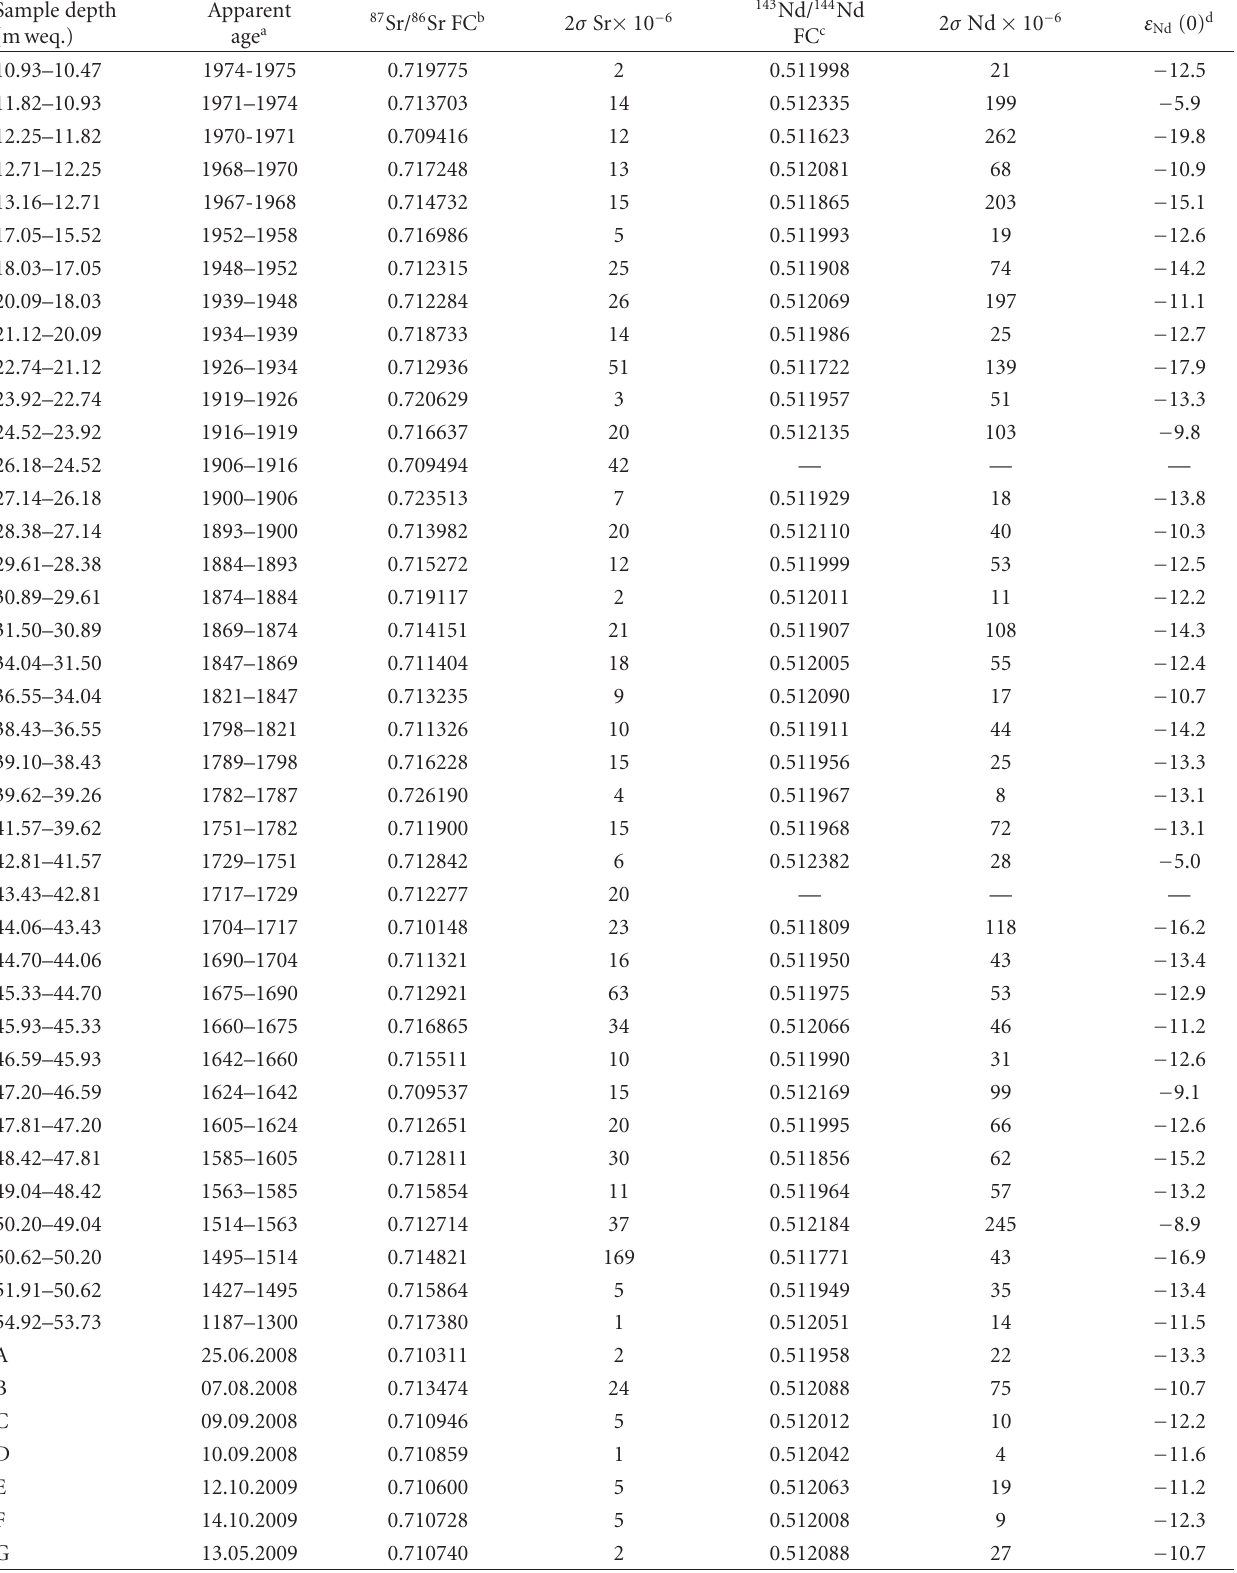
Table 1: Sample depth (meter water equivalent, mweq.) for the Colle Gnifetti (CG) ice-core samples (upper part), sample name for the Jungfraujoch (JFJ) samples (lower part), age of sample, 87 Sr/ 86 Sr and 143 Nd/ 144 Nd isotopic compositions with 2 σ (2 standard errors of the mean), and Nd isotopic ratios expressed as epsilon